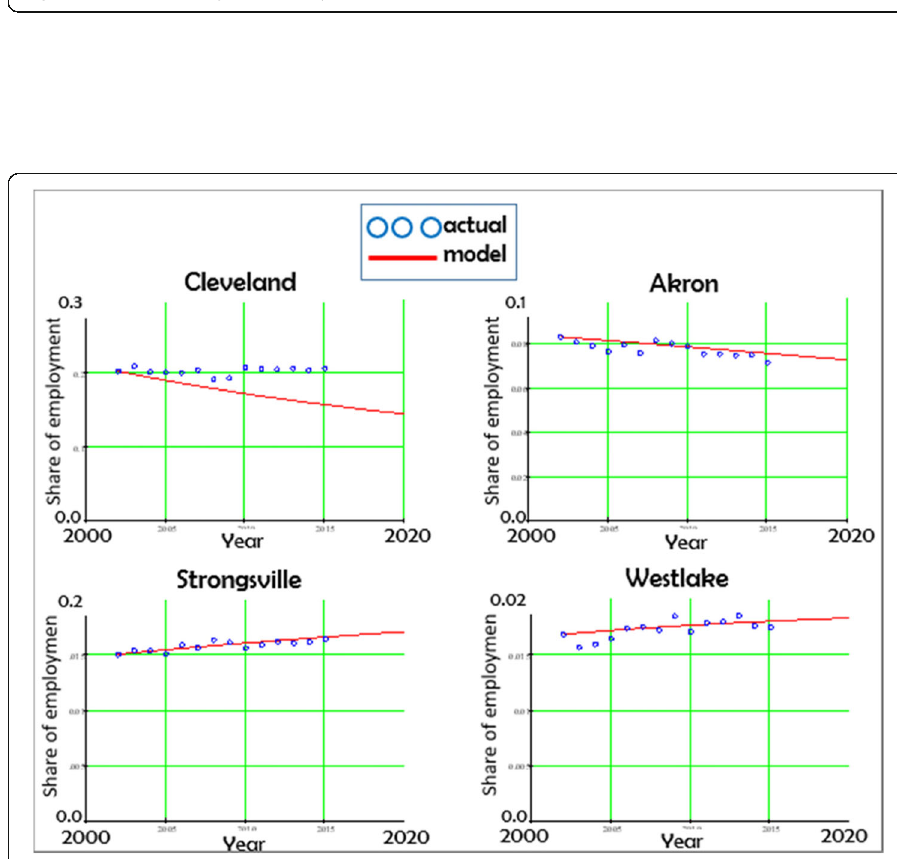
Fig. 7 Shares of total regional employment in 4 Northeast Ohio cities, 2002 –